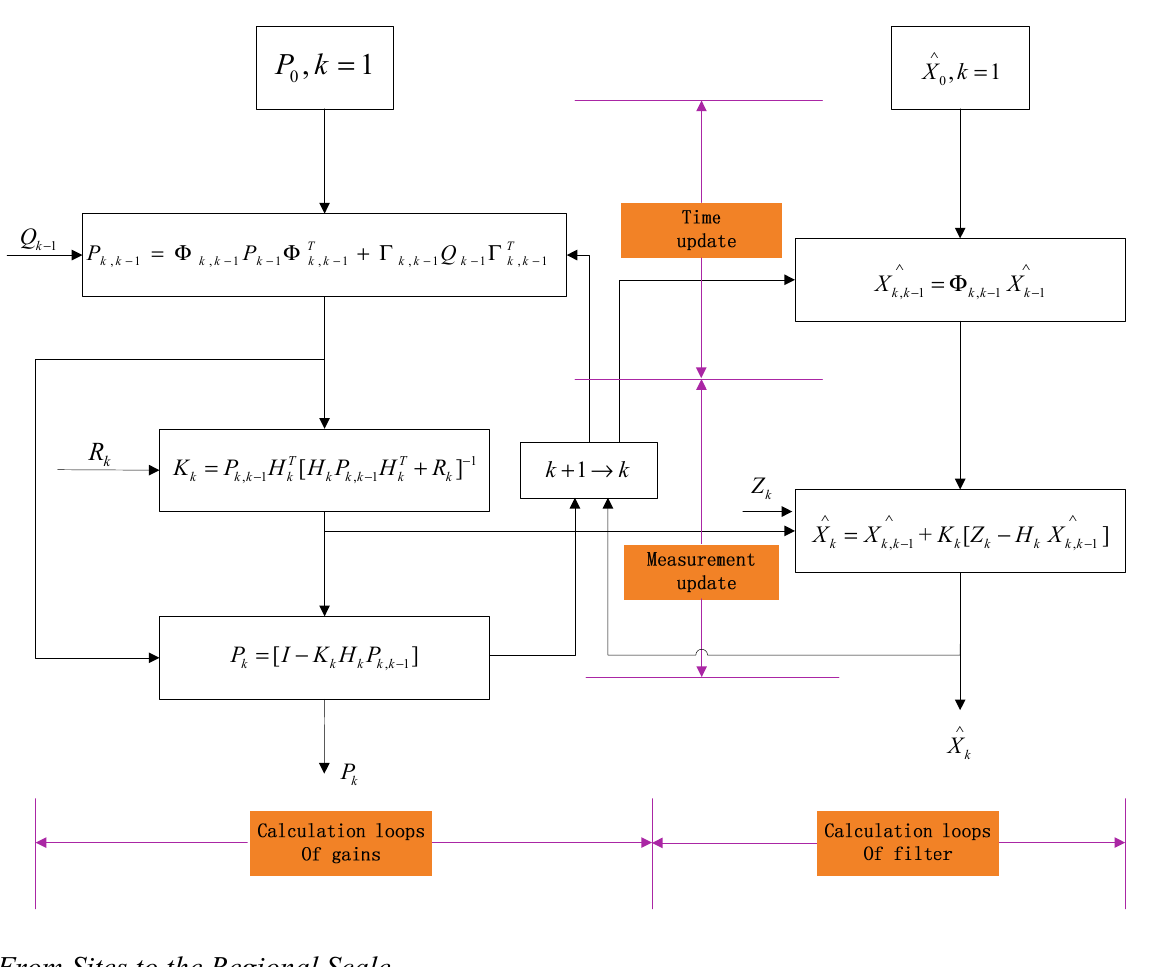
Figure 2. Algorithm Diagram of the Kalman